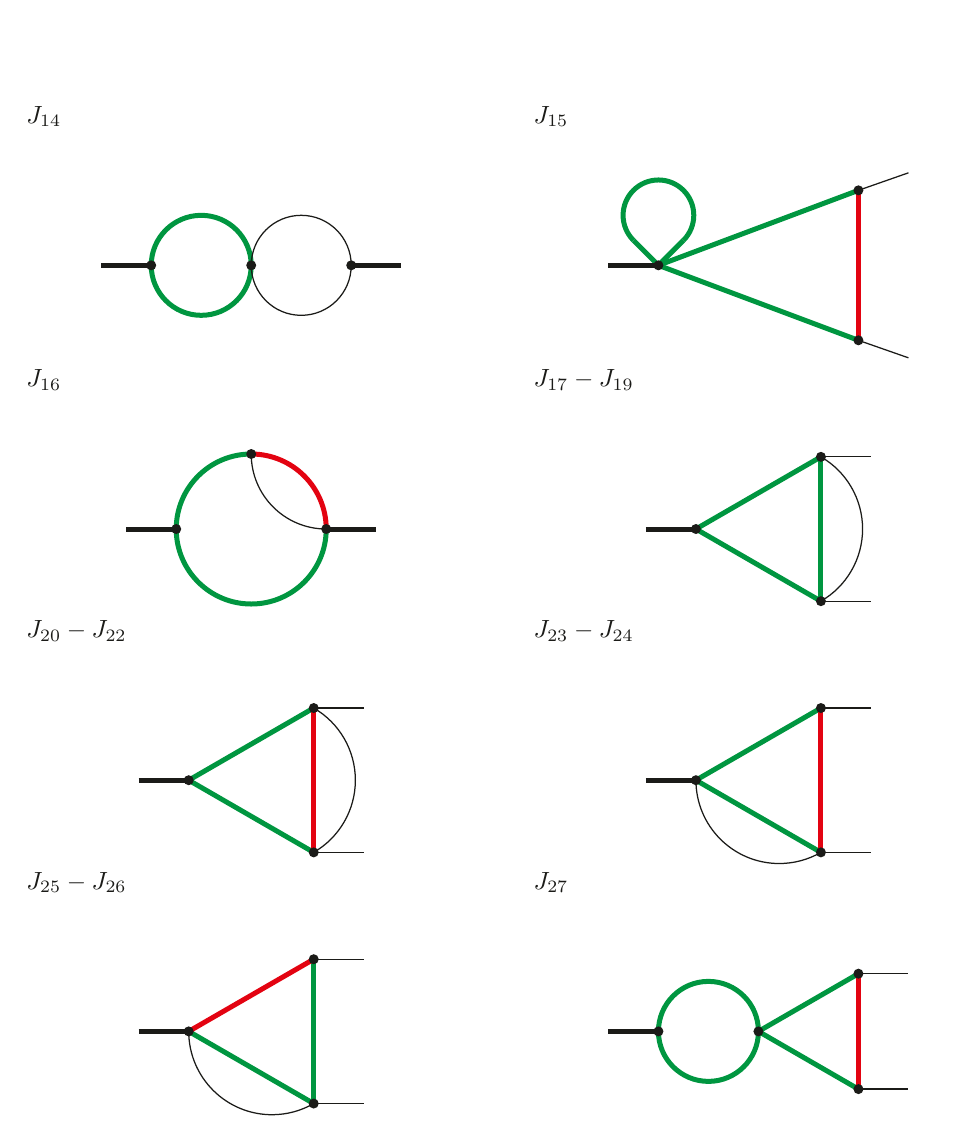
Figure 5 . Master topologies (part